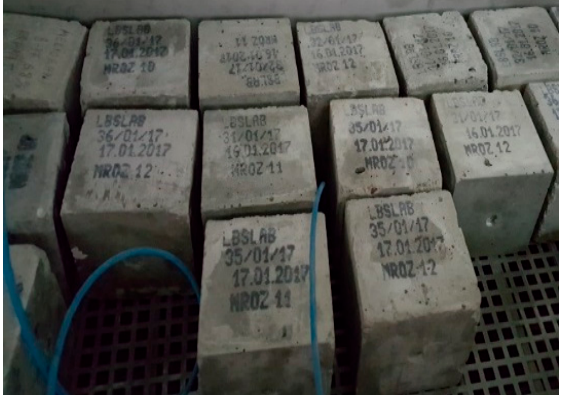
Figure 3. Water-tightness test of concretes. Figure 4. Frost resistance test of concretes.